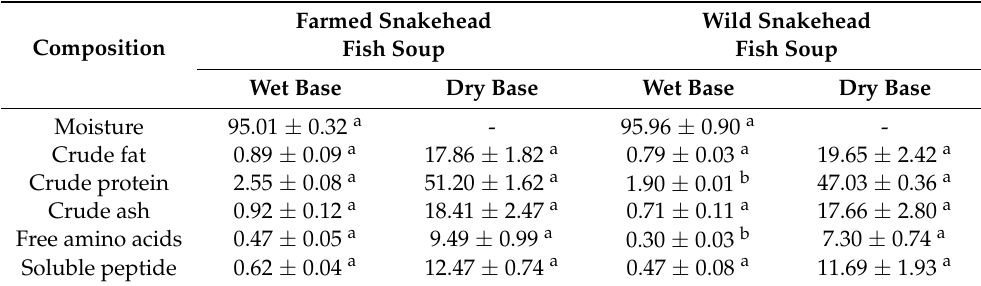
Table 1. Proximate composition of soup made from farmed and wild snakehead fish. Composition